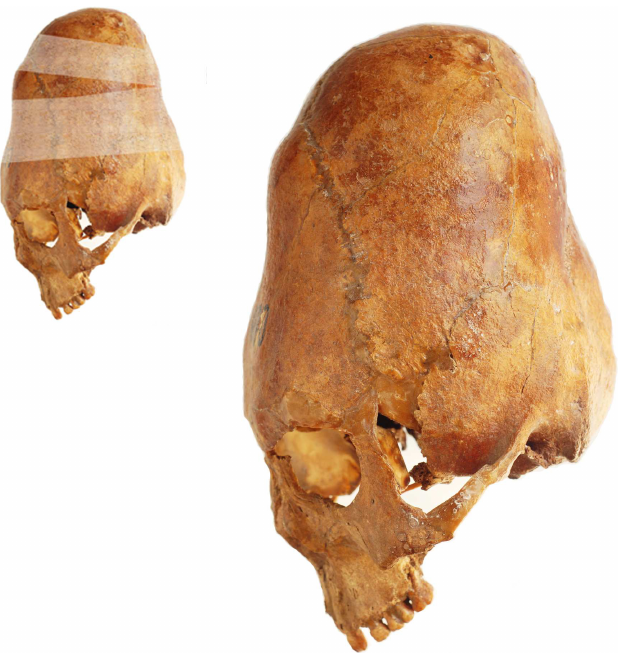
Fig 5. Georgian cranium used in this study demonstrating the effect of the annular form of modification, with several circular bandages resulting in a tall, vertical cranial profile. The orientation of the cranium is that used in the eigenshape analysisin this